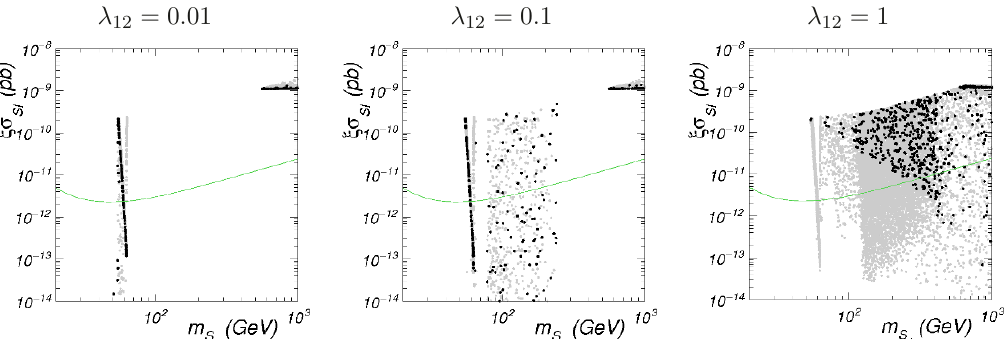
Figure 9 . Spin-independent scattering cross section of S 1 with protons as a function of its mass in the ESHP model. From left to right, we have fixed λ 12 = 0 . 01 , 0 , 1, and 1,